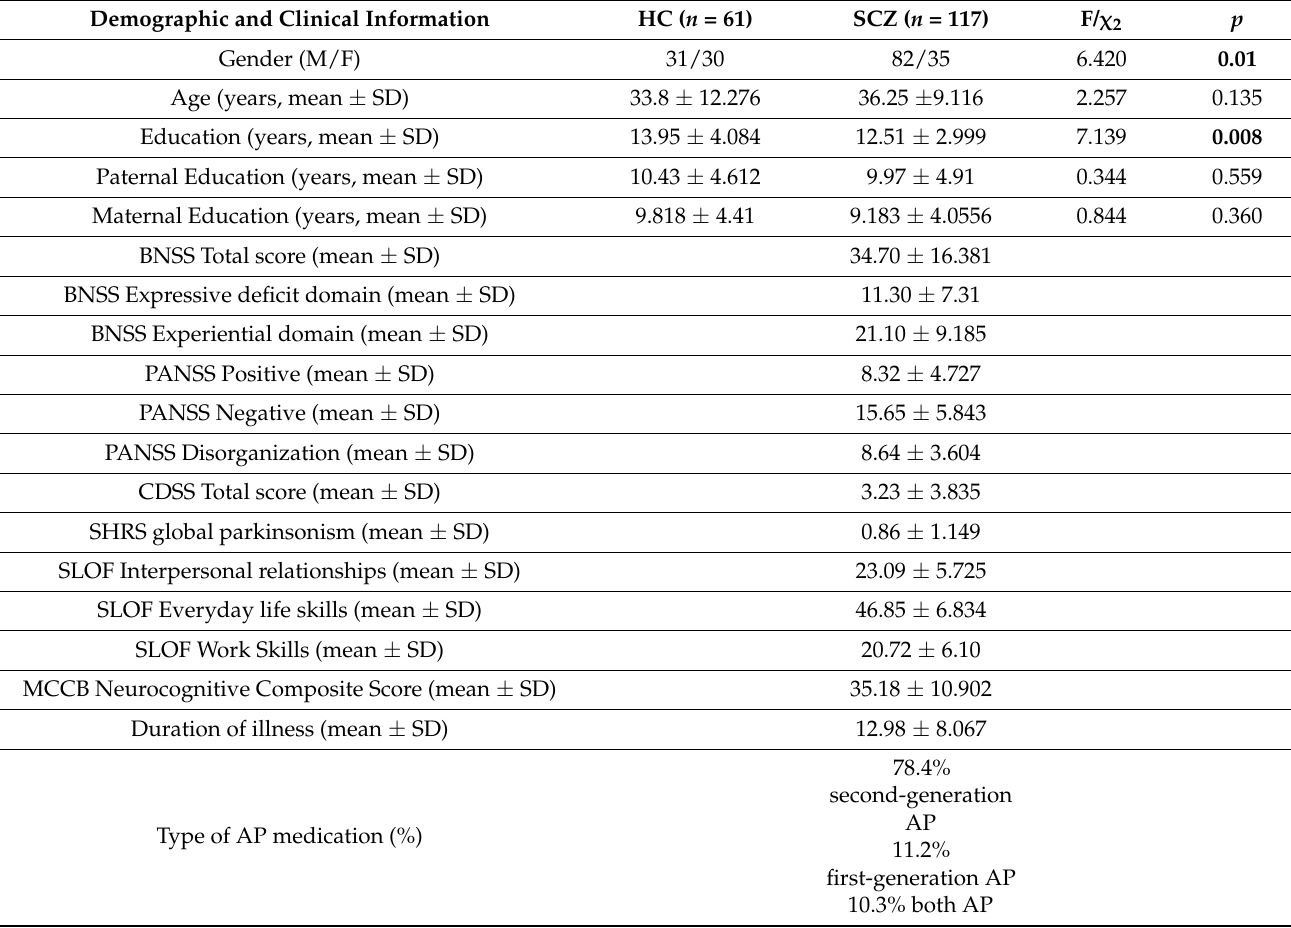
Table 1. Demographic and clinical characteristics of the study